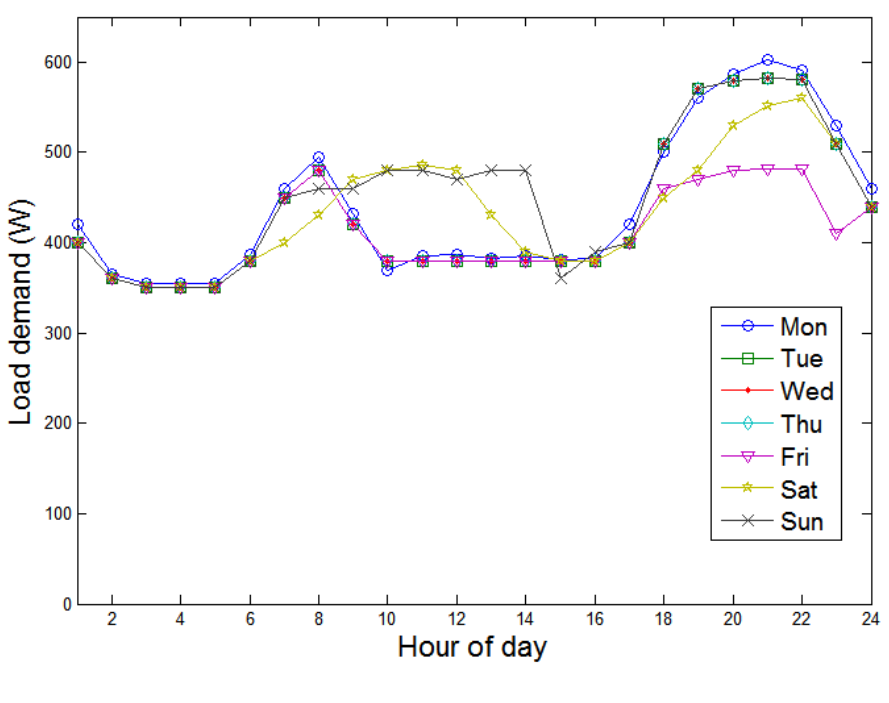
Figure 5. Daily fluctuations in load demand, temperature and the number of people in the